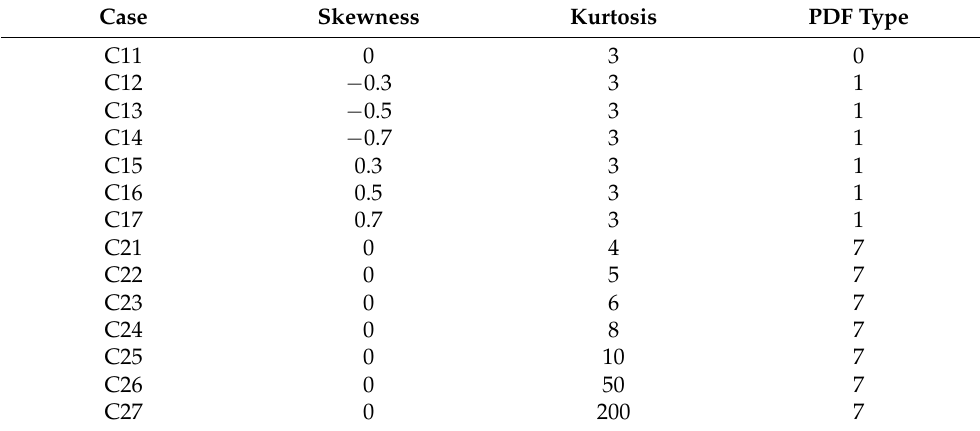
Table 2. Numerical example of Pearson distribution of NLFE: (mean: 0, standard deviation: